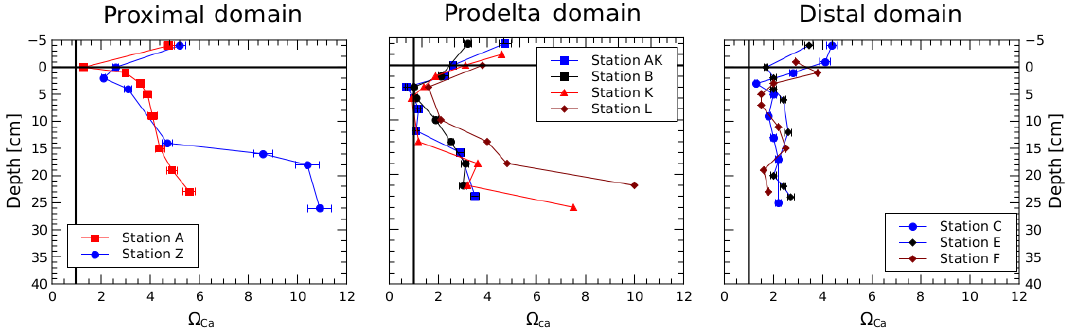
Figure 9. Porewater calcium carbonate saturation state ( (cid:127)) of the proximal, prodelta and distal domains. The saturation limit for calcium carbonates dissolution/precipitation ( (cid:127) = 1) is marked by a vertical